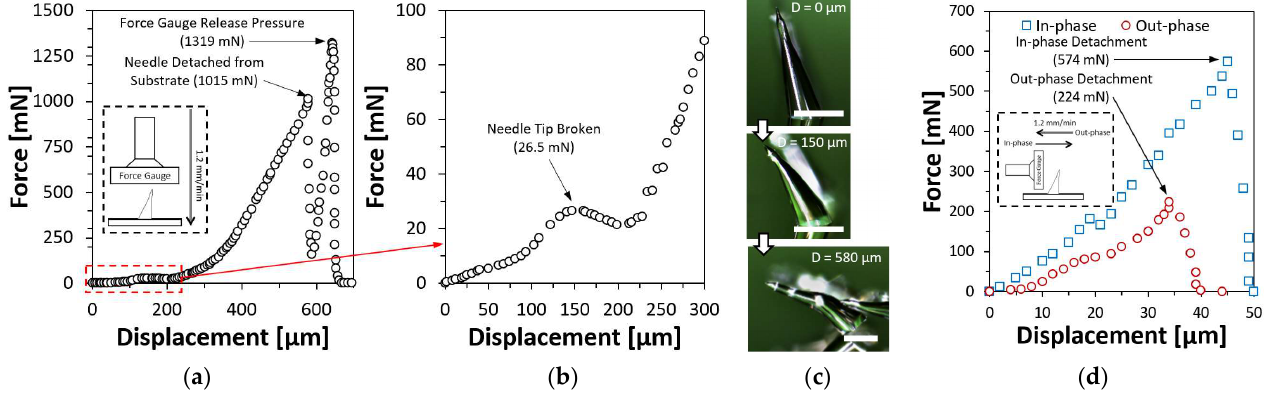
Figure 8. Force-displacement test results on a single resin-based inclined first bell-tip microneedle. ( a ) Force-displacement test result with vertical compression. ( b ) Zoomed-in at the first 300 µm displacement to visualize the force drop while the needle tip was broken. ( c ) Compressed microneedle. Scale bar = 200 µm. ( d ) Force-displacement test with in-phase and out-phase compression.